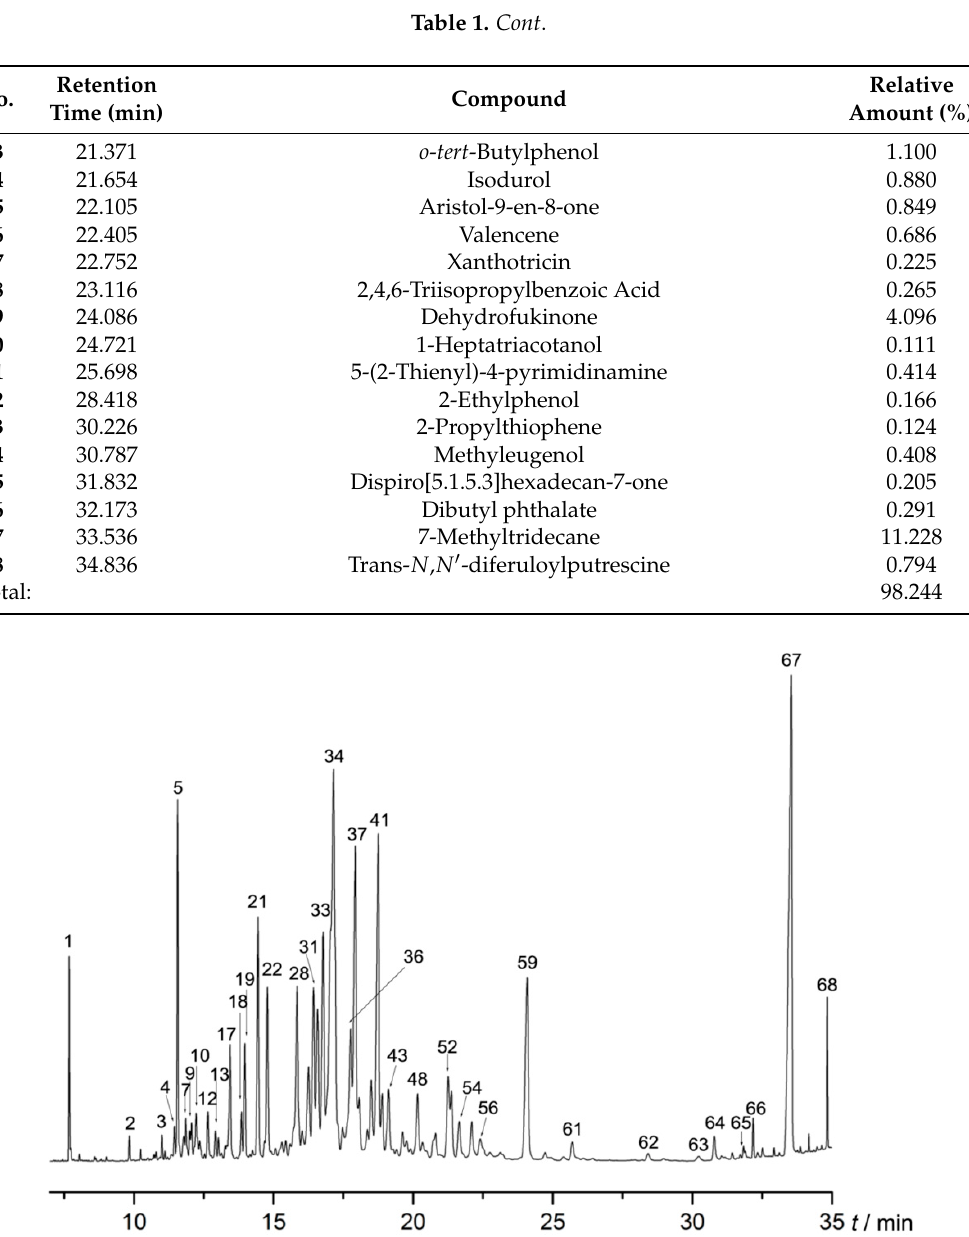
Figure 1. Gas chromatograph mass spectrometry (GC-MS) chromatograms of agarwood essential oil (AEO).